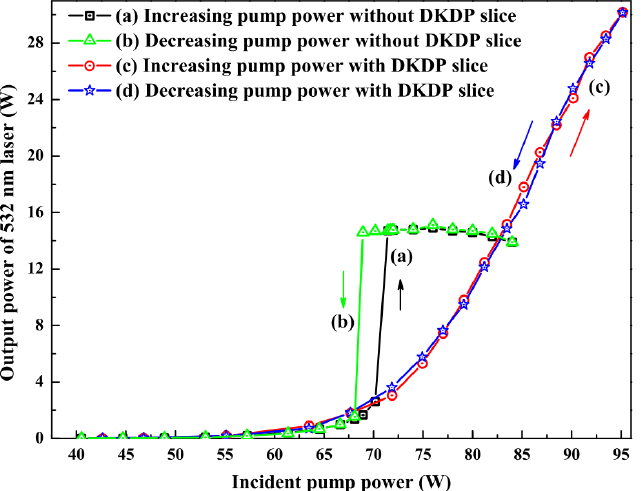
Figure 12. Output power of 532 nm laser versus pump power before and after the 1.6-mm-thick DKDP slice was inserted into the laser resonator [27]. Reprinted with permission from [27] c (cid:13) The Optical